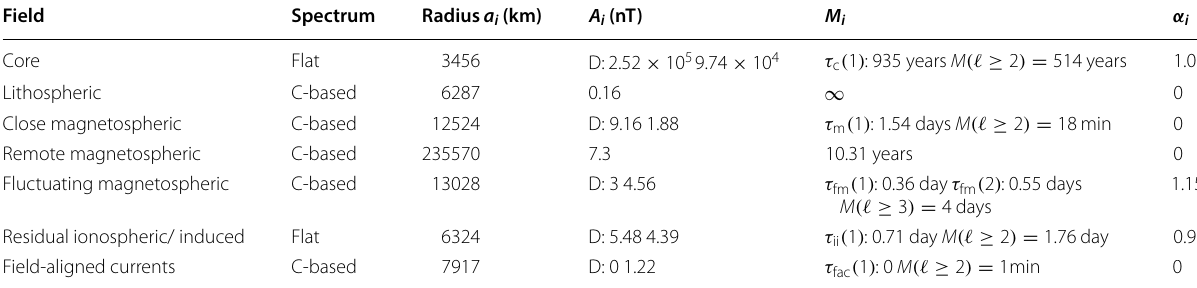
Table 2 Magnetic sources parameters as described in "Magnetic sources" section